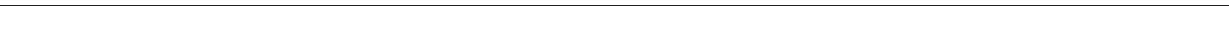
Fig. 4 Validation of impactful PIK3CA mutation-induced phenotypes related to proliferation and drug response. a The frequencies of impactful PIK3CA mutations (proliferation, doxorubicin, and BKM120 responses) in the FUSCC, COSMIC, and TCGA data sets. b Schematic representation of the locations of impactful amino acid substitutions in the PI3K/PI4K, C2 PI3K-type, PIK helical, and PI3K-ABD domains of PIK3CA (proliferation, black; doxorubicin, red; BKM120, blue). c The locations of the impactful mutations in the dimensional structure of the PIK3CA -encoded p110 α protein are illustrated. Colors denote mutant residues within the corresponding domains in b . d Growth curves of MCF-10A cells expressing PIK3CA wild type and mutants were determined in the absence of EGF using an incucyte cell imaging system. Five wells were measured per condition. The error bars shown are mean ± s.d. of 5 technical replicates from a representative of three independent experiments. (* P < 0.05, for Student ’ s t test). e The effects of PIK3CA mutations on acinar morphogenesis by mammary cells cultured on a bed of Matrigel were assessed. Representative images of acini were obtained on Day 11. The dot plot shows the size distribution and the mean (horizontal line) for each cell line ( n ≥ 3, >60 acini per experiment; Mann – Whitney test: *** P < 0.0001; n.s. not signi fi cant). Scale bar, 100 µ m. f Activation status of PI3K pathway components in the indicated cells in response to growth factors (EGF and insulin). MCF- 10A cells expressing wild-type or mutant PIK3CA were seeded in growth medium for 24 h and then cultured in starvation medium ( − ) or in growth medium (G) containing 20 ng ml − 1 EGF and 10 µ g ml − 1 insulin for an additional 24 h. The cells were immunoblotted with the indicated antibodies. Western blots were representative of three independent experiments. g Activation status of p-AKT (Ser473) after the addition of increasing concentrations of EGF. The cell lines were deprived of EGF and insulin for 24 h and then stimulated for 10 min with increasing concentrations of EGF. Western blots were representative of three independent experiments. h Activation status of p-AKT (Ser473) after increasing concentrations of BKM120 were added to cultures of the indicated cell lines. The cell lines were cultured in starvation medium for 24 h and then treated with increasing concentrations of BKM120 for 1 h. The lysates were subjected to western blotting. Western blots were representative of three independent experiments. i , j Growth curves of MCF-10A cells expressing PIK3CA wild-type and mutants with doxorubicin or BKM120. Five wells were measured per condition. Error bars represent mean ± s.d. derived from three independent experiments. (** P < 0.01, for Student ’ s t